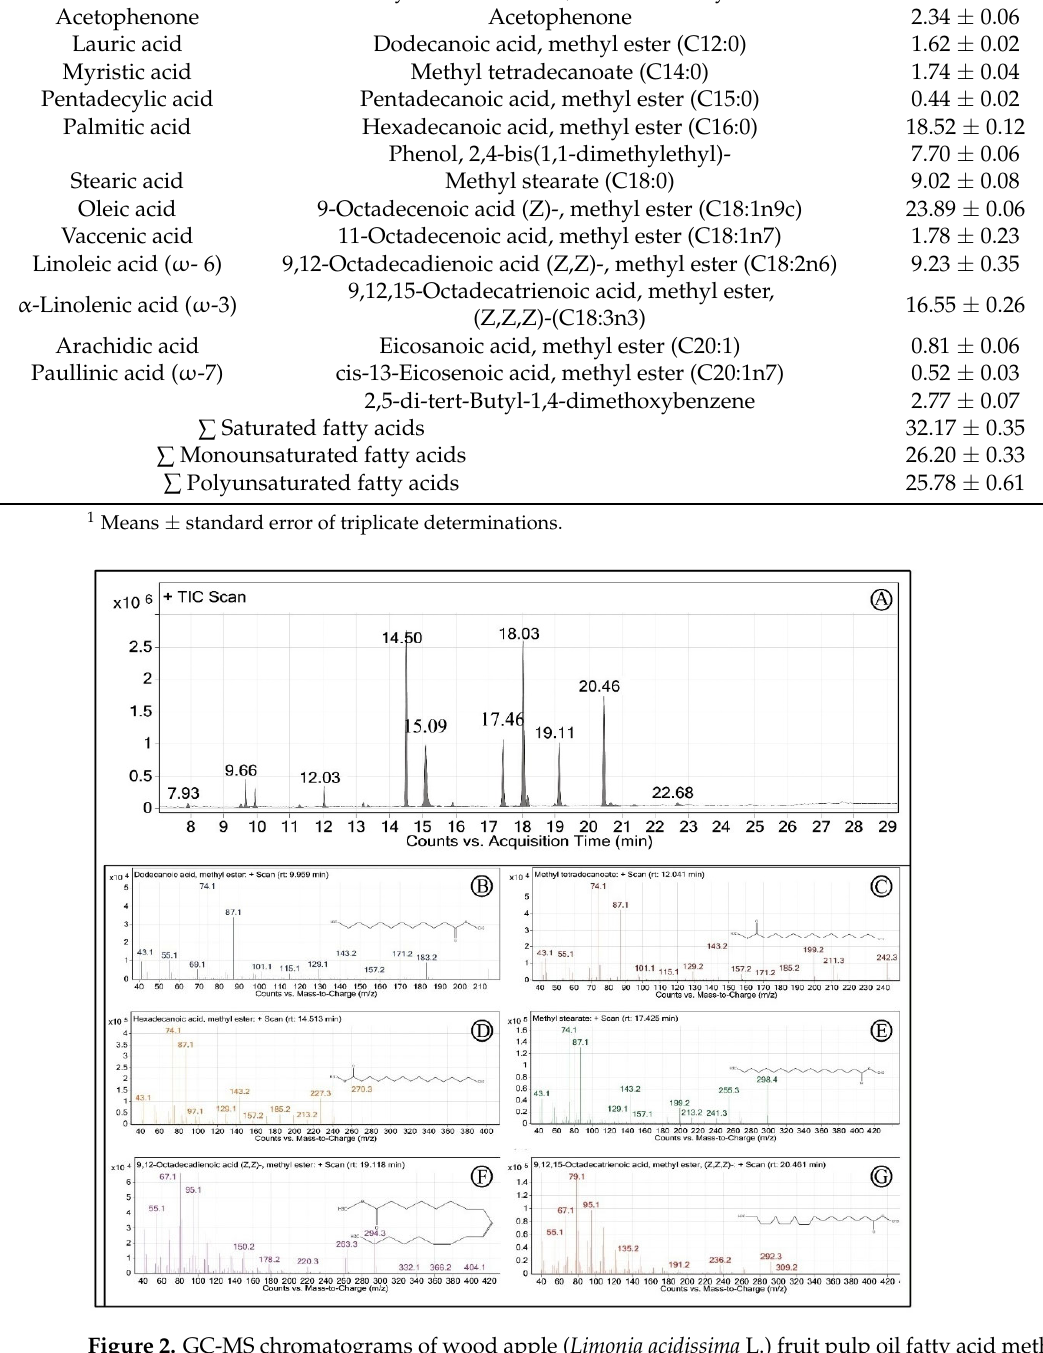
Figure 2. GC-MS chromatograms of wood apple ( Limonia acidissima L.) fruit pulp oil fatty acid methyl esters (FAMEs) ( A ) and MS spectra of major FAMEs of analyzed fatty acids. Dodecanoic acid ( B ), methyl tetradecanoate ( C ), methyl palmitate ( D ), methyl stearate ( E ), methyl linoleate ( F ), methyl linolenate ( G ).